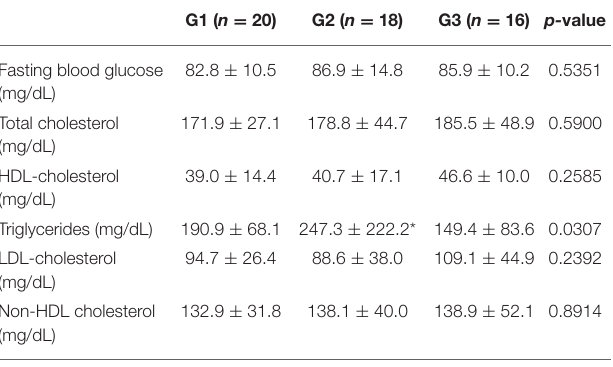
TABLE 2 | Metabolic profile of men stratified by group of people living with HIV/AIDS with (G1) and without HALS (G2) and control group (G3). G1 ( n = 20) G2 ( n = 18) G3 ( n = 16) p- value Fasting blood glucose (mg/dL)